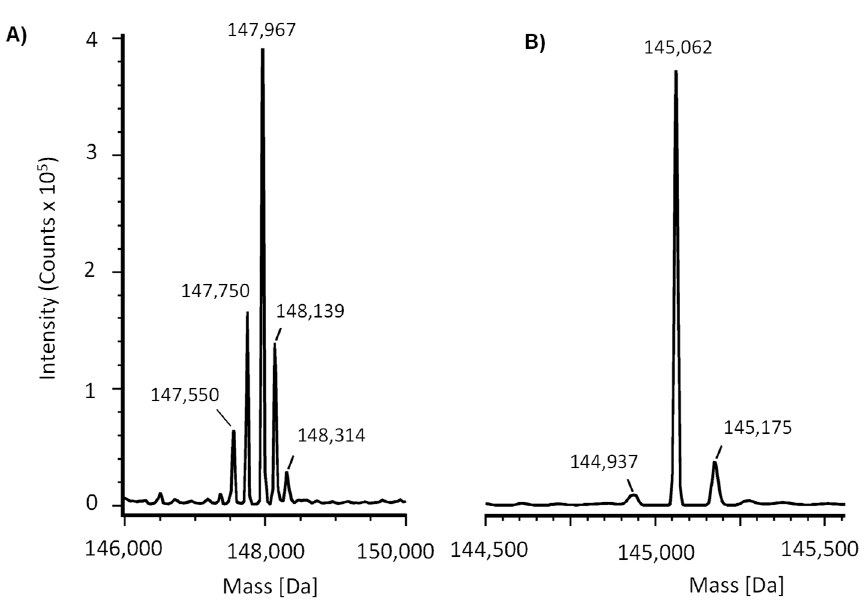
Figure 2. Mass Spectrometry analysis of IgG-A7, a broadly SARS-CoV-2 neutralizing antibody. Main isoforms of the intact ( A ) and deglycosylated ( B ) molecules.